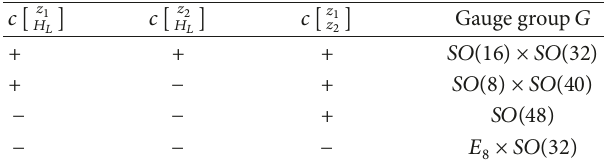
Table 1: The configuration of the symmetry group with four basis